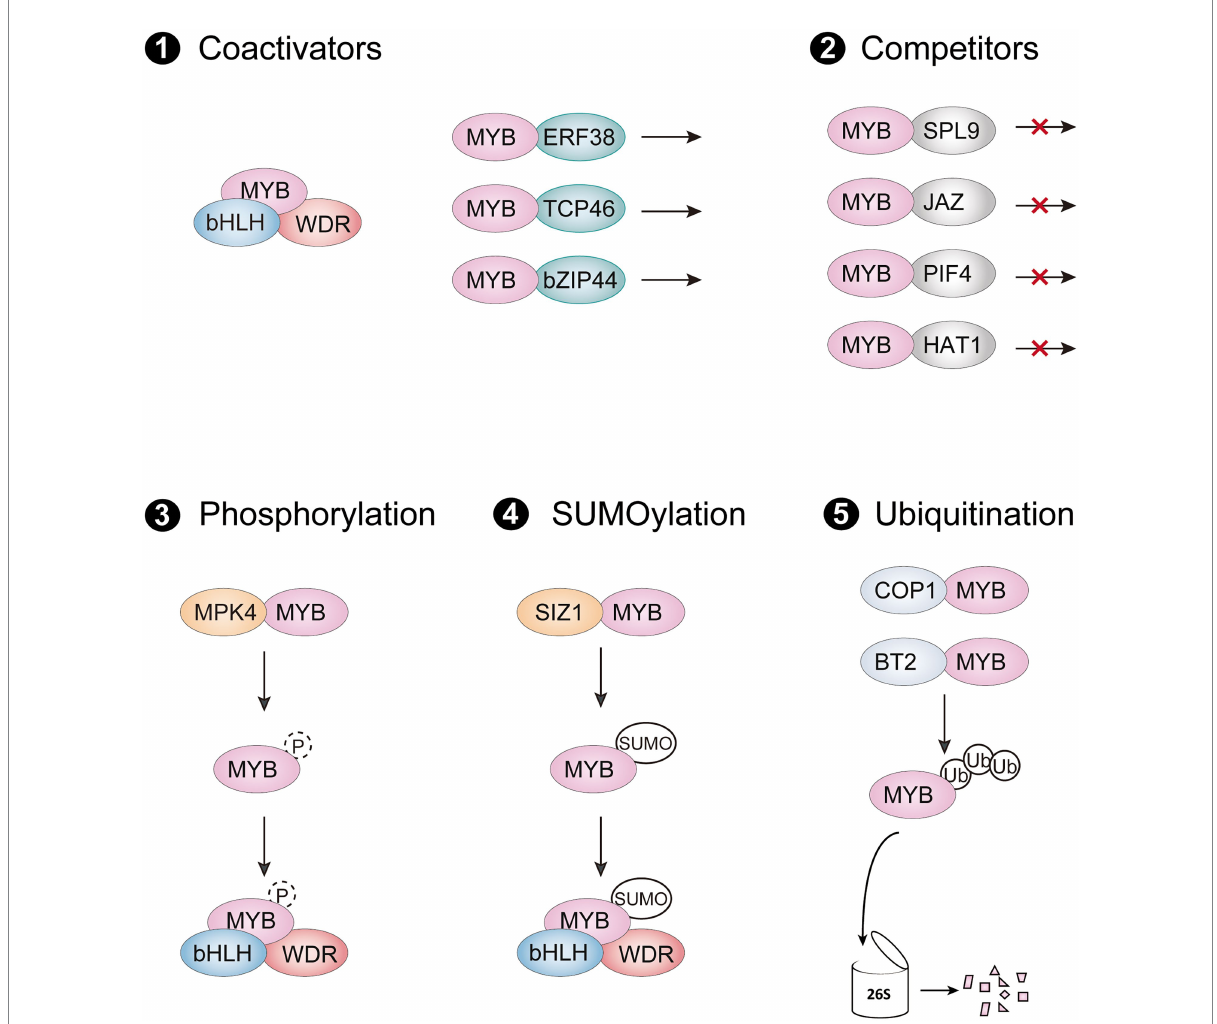
FIGURE 3 Posttranslational regulation of R2R3-MYB activators. (1) R2R3-MYBs form an active MBW complex with bHLHs and WDR protein, or they interact with other coactivators to promote their transcriptional activity. (2) The interaction of R2R3-MYB activator with competitors interferes stabilization of the MBW complex and represses their activation of anthocyanin biosynthetic genes (3–5). R2R3-MYB activators can be regulated through posttranslational modifications such as phosphorylation (3), SUMOylation (4), and ubiquitination (5). SUMO, small ubiquitin-like modifier; Ub, ubiquitin